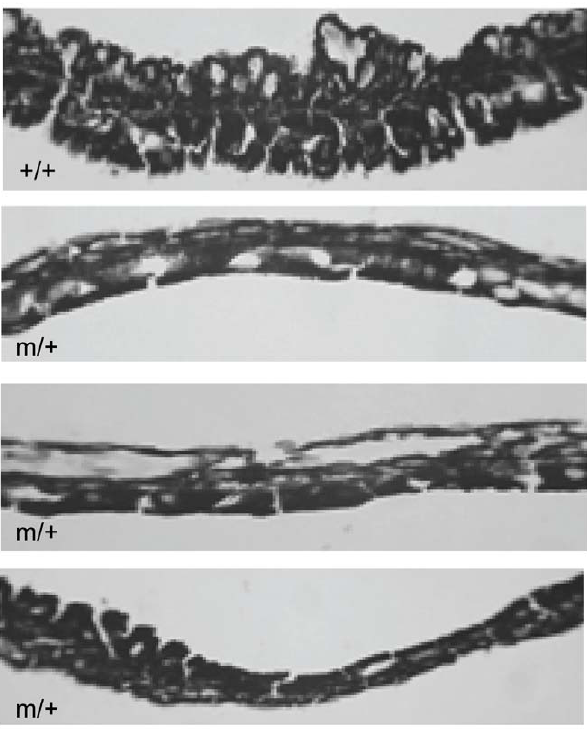
Figure 3. Iris phenotype of Foxf2 W174R mice. The iris in wildtype mice ( + / + ) consists of a robust upper stromal layer (arrowhead) and a lower pigmented epithelium (arrow). The stroma in three heterozygous (m/ + ) mice is flattened or atrophic. The bottom image shows variable thickness across the iris tissue in both stromal and epithelial layers. Scale bar =40 m m.